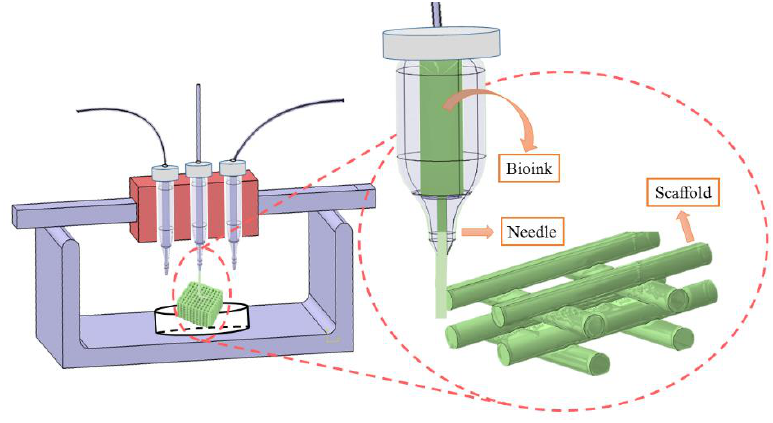
Figure 1. Schematic of 3D bioplotting.